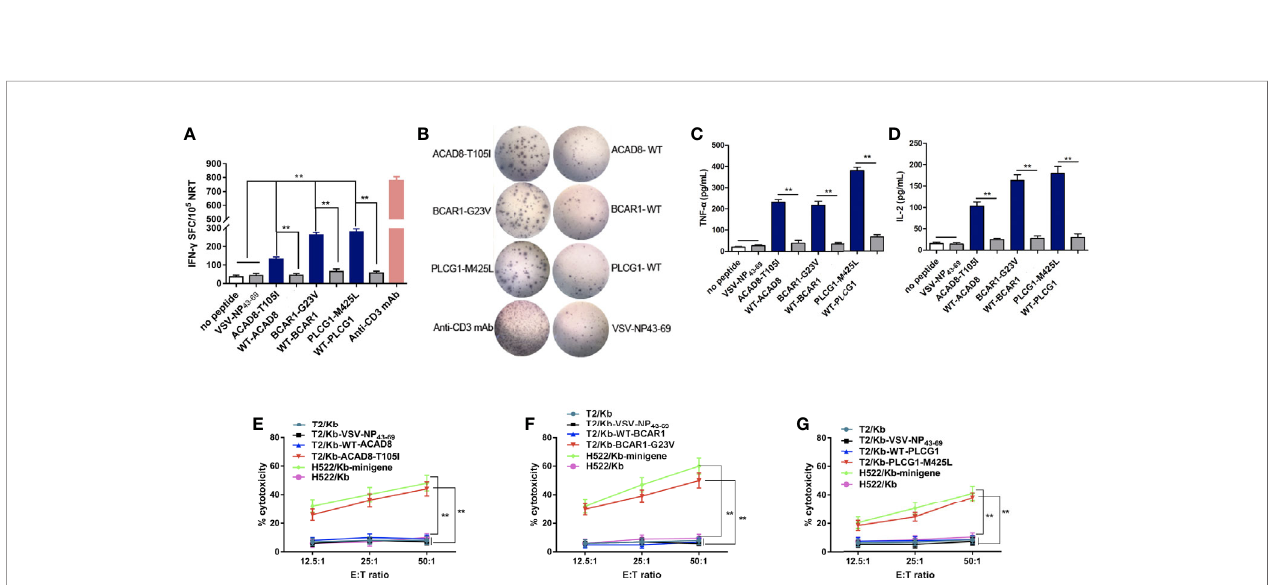
FIGURE 4 | ACAD8-T105I, BCAR1-G23V and PLCG1-M425Linduce more ef fi cient NRT responses than WT epitopes in HLA-A2.1/K b Tg mice. (A – D) Splenocytes of mice(n=5) vaccinated with mutated peptides were tested by ELISPOT assay for the recognition of mutated peptides compared with the corresponding wild-type sequences. The data are presented as the means ± s.e.m.s from three independent experiments. ** P < 0.01 was obtained in the comparison of IFN- g (A, B) , TNF- a (C) and IL-2 (D) production by splenocytes stimulated without a peptide or with VSV-NP43-69. (E – G) Splenocytes from HLA-A2.1/K b Tg mice immunized with mutated peptides were re-stimulated in vitro with the corresponding mutated peptide for 7 days. The ex vivo cytotoxicity against the corresponding mutated peptide- pulsed T2/Kb cells and minigene-nucleofected H522/Kb cells at the indicated E:T ratio was examined using time-resolved fl uorescence assay. Irrelevant peptide VSV-NP43-69-pulsed T2/Kb cells, T2/Kb cells alone or H522/Kb cells were used as controls. Stimulation with anti-CD3-mAb was used as positive control. The data are presented as the means ± s.e.m.s from three independent experiments. ** P <0.01. E:T, effector: target; SFC, spot-forming cell; VSV-NP, vesicular stomatitis virus